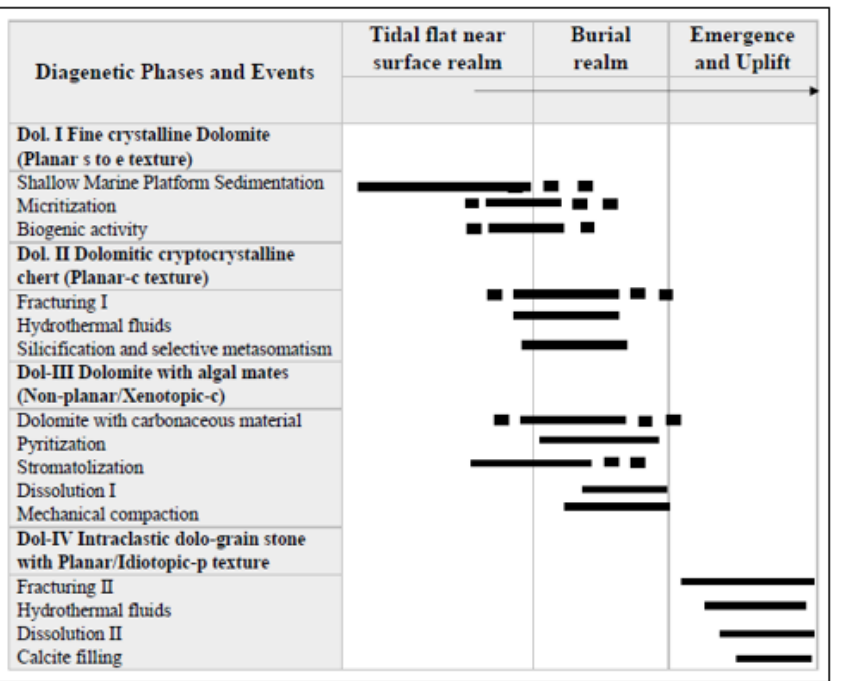
Figure 11. Paragenetic history of the dolomite of the Abbottabad Formation, representing early tidal flat period followed by s burial period and uplift.